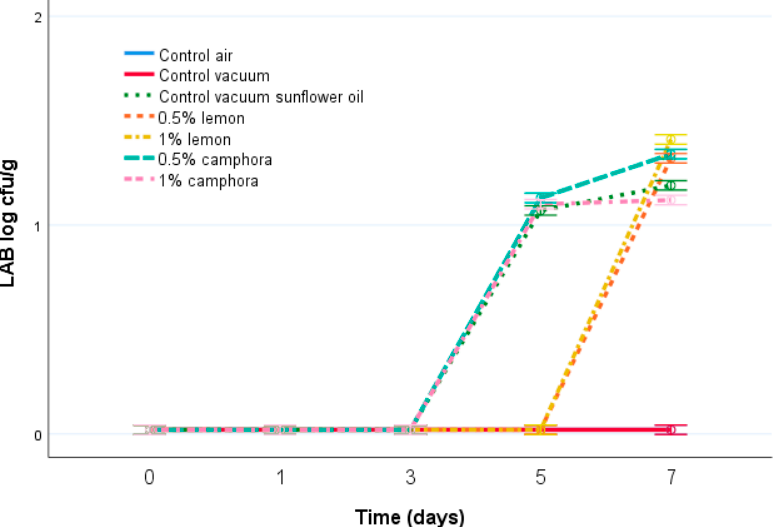
Figure 3. Evolution of counts of LAB (log cfu/g) in samples of rainbow trout during 7 days of storage at 4 ◦ C. Air control—aerobically packed control samples; vacuum control—vacuum-packed control samples; vegetable oil control—vacuum-packed control samples treated with sunflower oil; lemon EO 0.5—vacuum-packed samples treated with 0.5% lemon EO; lemon EO 1—vacuum-packed samples treated with 1.0% lemon EO; C. camphora EO 0.5—vacuum-packed samples treated with 0.5% C. camphora EO; and C. camphora EO 1—vacuum-packed samples treated with 1.0% C. camphora EO. Bars denote ± twice the standard error ( p <